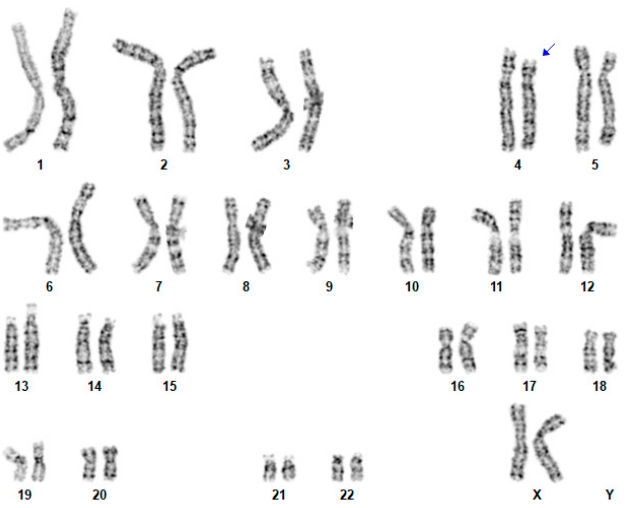
Figure 1. Conventional cytogenetic analysis on this proband. A karyotype 46,XX,del(4)(p15.2-p14). Blue arrow indicates where the proximal deletion is